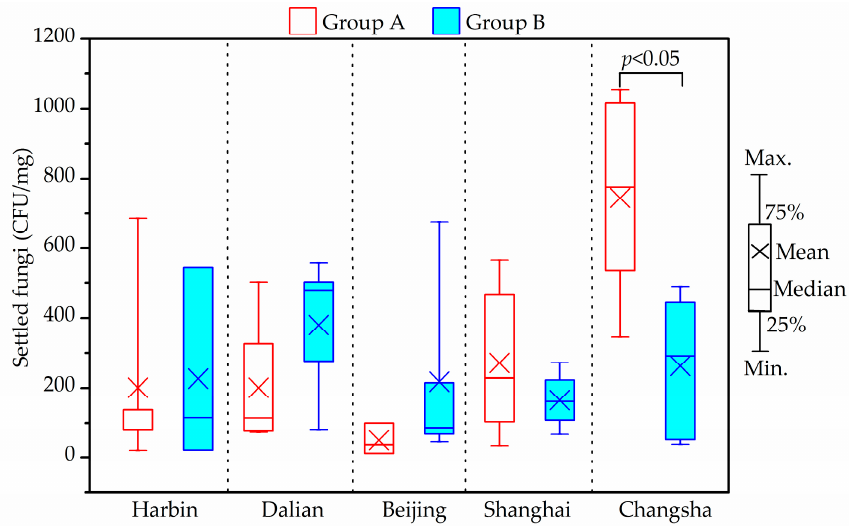
Figure 8. Indoor average level of settled fungi in house dust in winter.